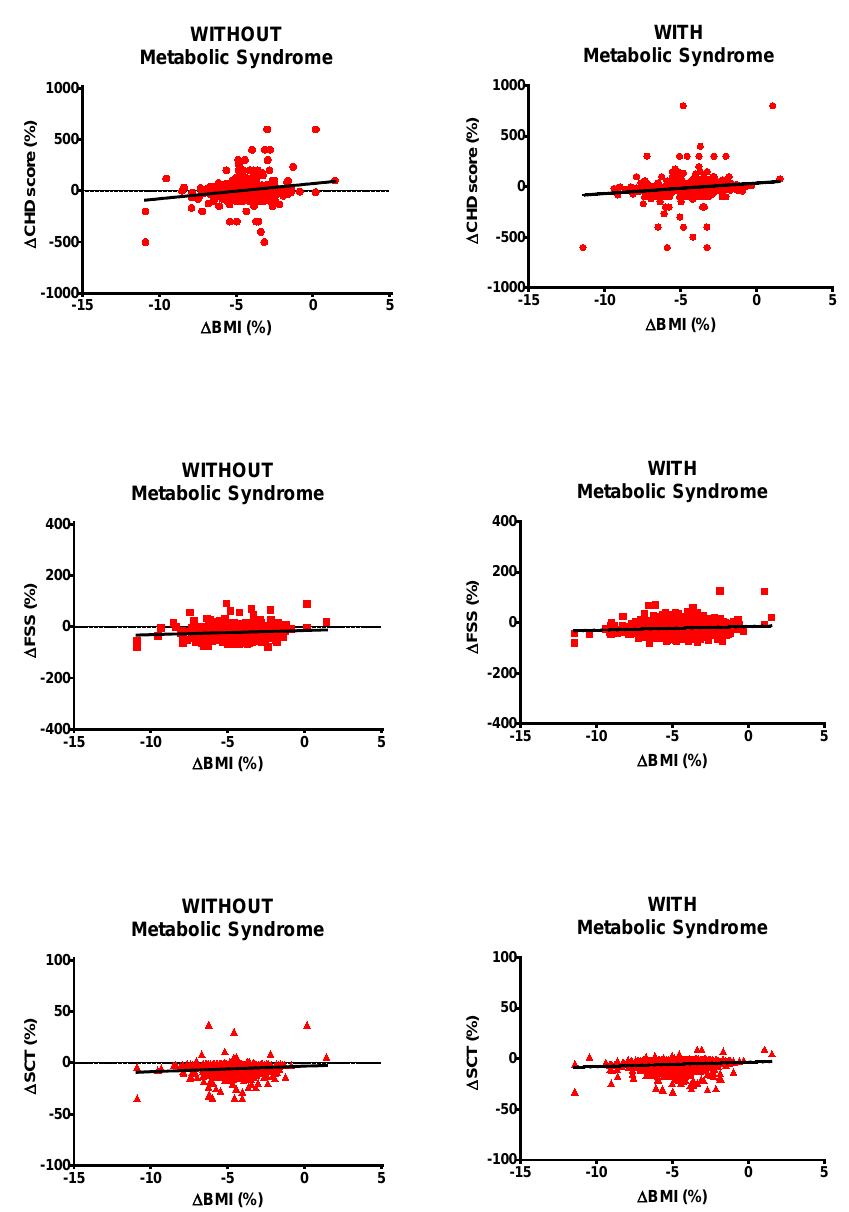
Figure 4. Correlations of ∆ BMI (body mass index) with ∆ CHD (coronary heart disease) score, ∆ FSS (fatigue severity score) and ∆ SCT (stair-climbing test) time for all obese subjects without (left panels) or with (right panels) metabolic syndrome. Please, note that ∆ means pre–post-BWRP percent change.